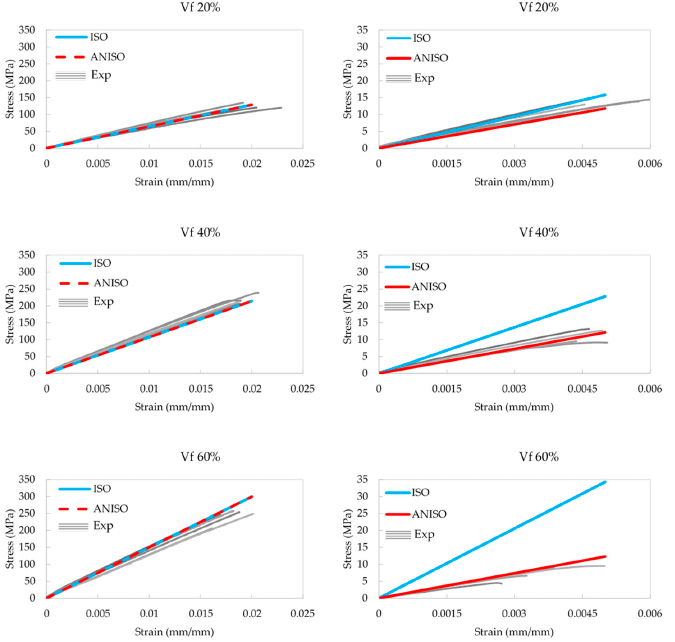
Figure 12. Experimental (gray) and numerical (blue and red) results of SFRC tensile tests: with axial load ( left column ) and off-axis load ( right column ).